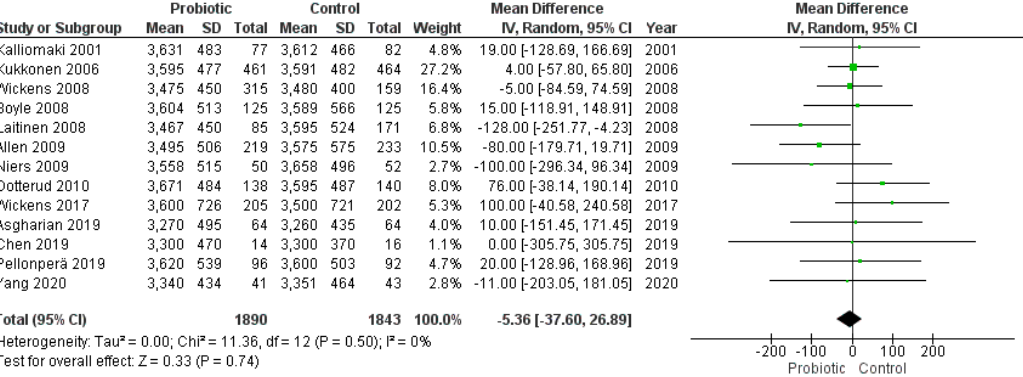
Figure 6. Meta-analysis of studies evaluating the administration of probiotic and birth weight.